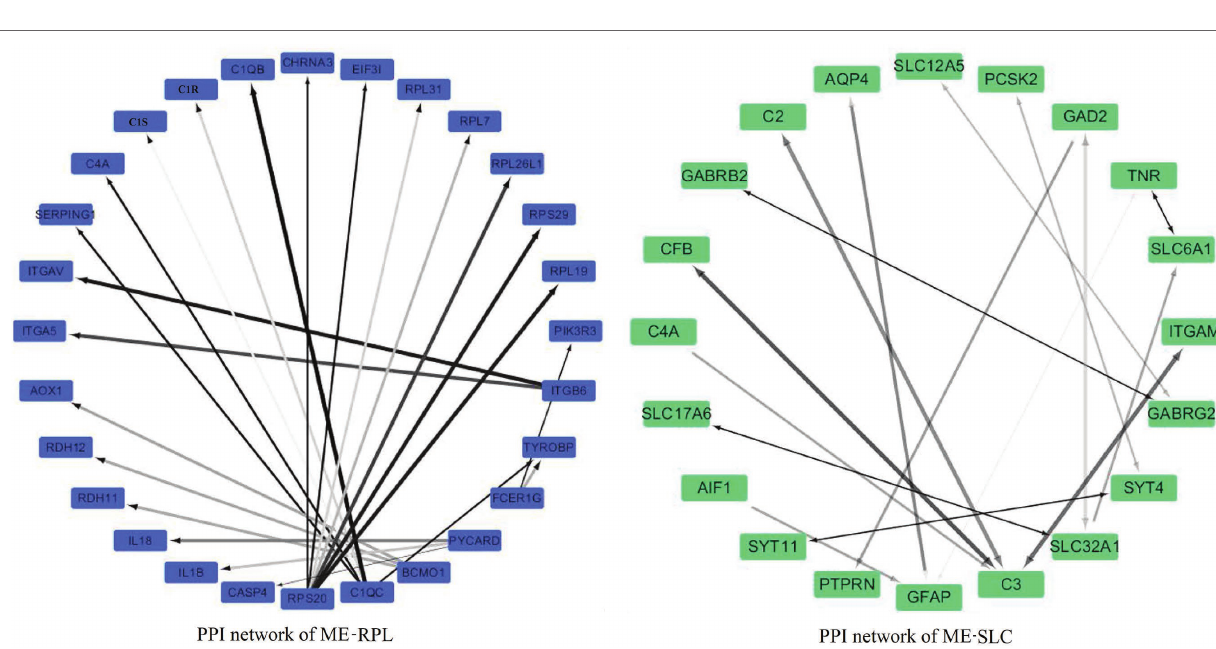
FIGURE 11 | PPI network of the DEGs in “ME-FASN.” Grayscale value of each line correlates with the strength of the interaction between the